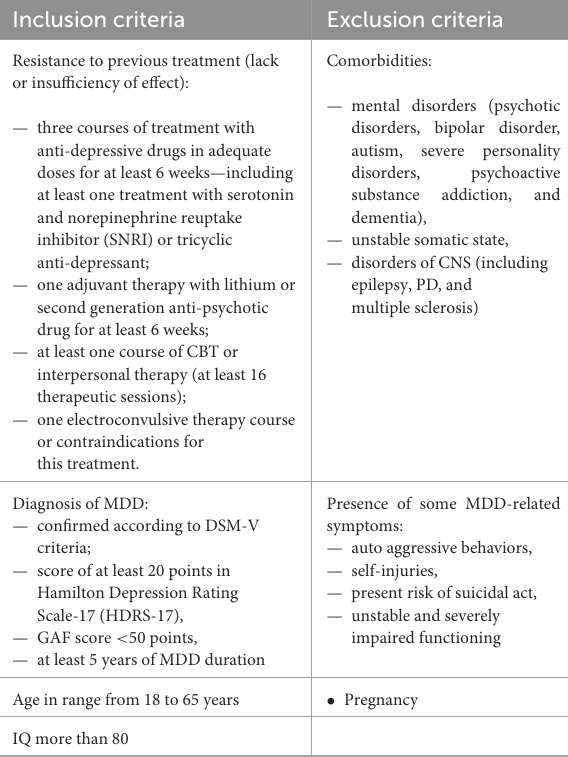
TABLE 1 Inclusion and exclusion criteria of the DBS in TRD study. Inclusion